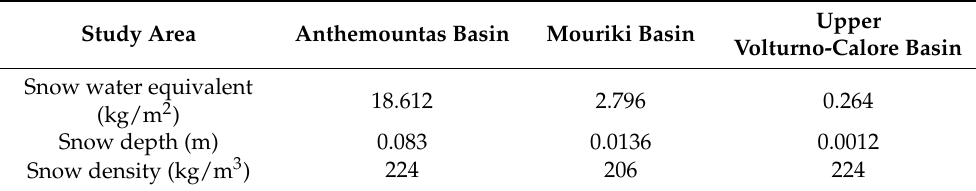
Table 2. Summary of the accumulative values of the snow water equivalent and the snow depth and the retrieved snow density values from the GLDAS dataset for the whole study period (1960–2021) as mean values of